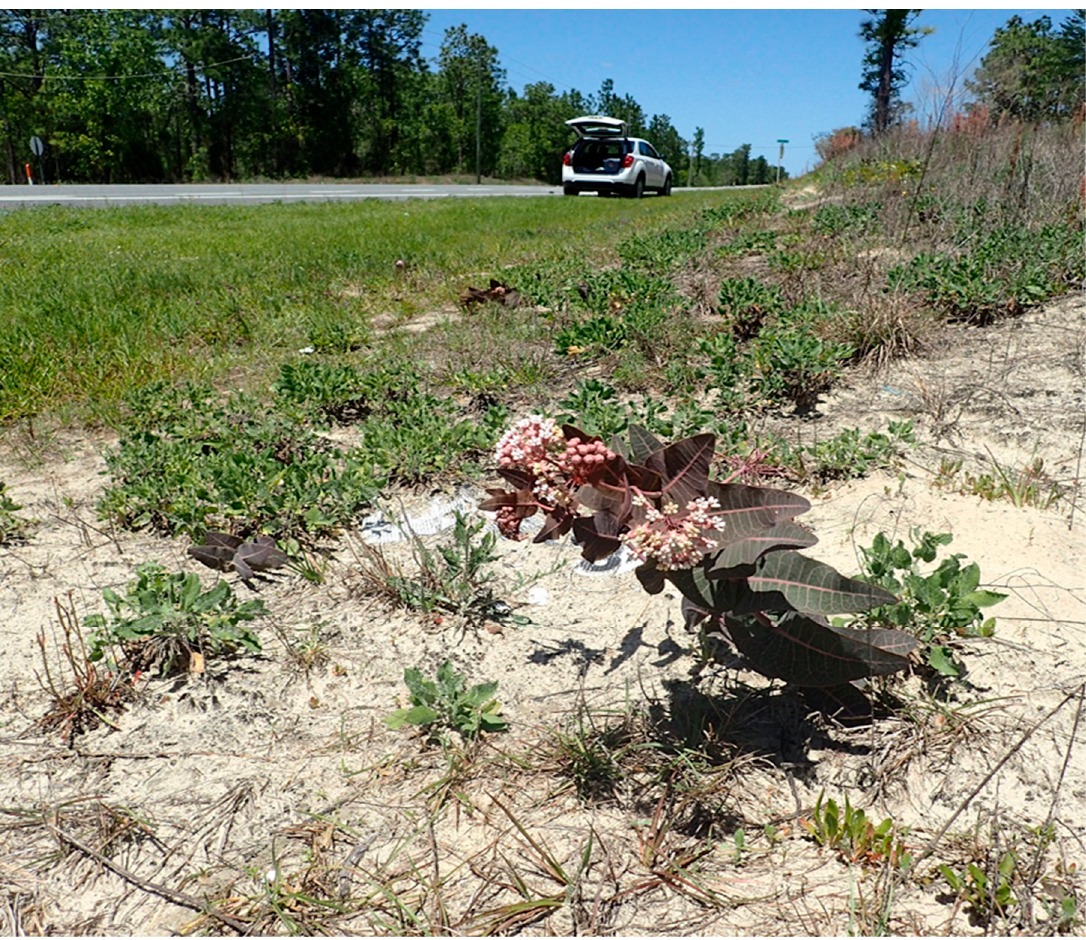
Figure 3. Road verge showing a population of pinewoods milkweed ( Asclepias humistrata ) with plants growing on the back upward sloped portion where exposed sand occurs.